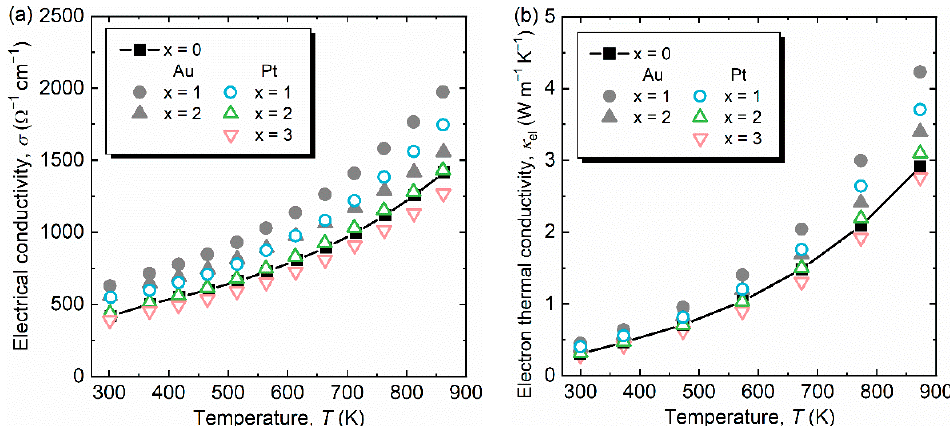
Figure 4. ( a ) Electrical conductivity σ and ( b ) electron thermal conductivity κ el as a function of temperature for Al 63 Cu 25 − x (Au,Pt) x Fe 12 ( x = 0, 1, 2, 3). Al 63 Cu 22 Au 3 Fe 12 is excluded because of secondary phase precipitation.